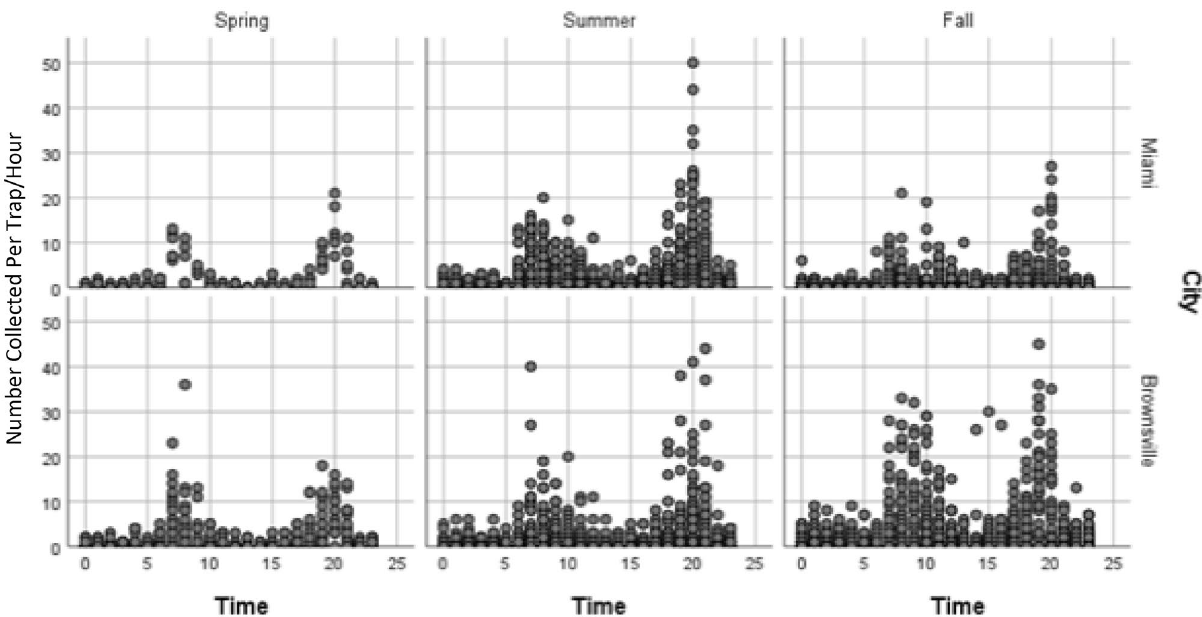
Figure 3. Diel activity patterns of Ae. aegypti in different seasons (Spring March–June, Summer June – September, Fall September–December). The y axis is the relative abundance of female Ae. aegypti ; the number of female Ae. aegypti captured per trap/hour at all sites in each